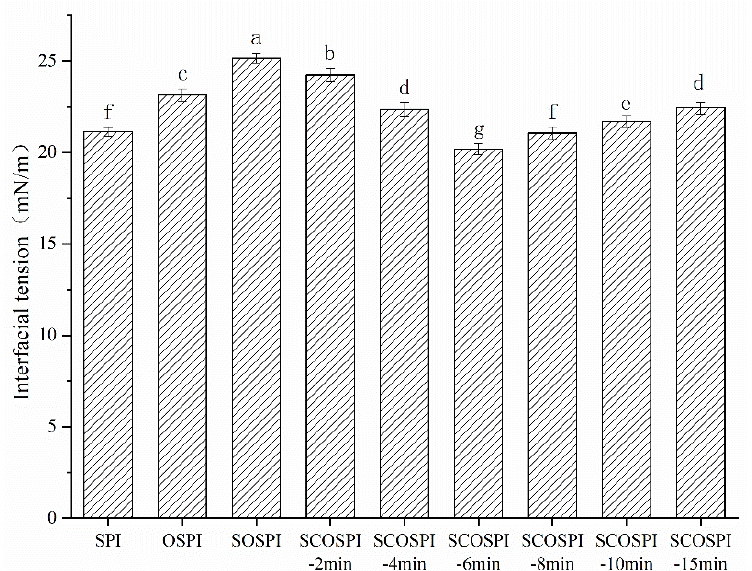
Figure 8. Interfacial tension of emulsions of natural, oxidized soybean protein, and cavitation jet treated on soluble soybean protein oxidized accumulates at several times (2, 4, 6, 8, 10, and 15 min). Note: Values with a different letter(s) indicate a significant difference at p ≤ 0.05.